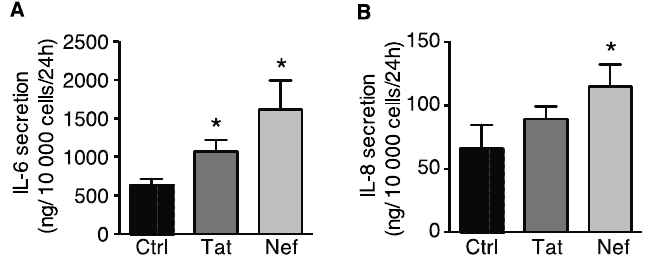
Figure 3. Elevated levels of interleukin (IL)-6 and IL-8 secreted into the culture medium of Tat- or Nef-treated ASCs. After 15 days of treatment with Tat or Nef, the levels of ( A ) IL-6 and ( B ) IL-8 in the culture medium from the last 24 h were determined with ELISAs ( n = 3, in duplicate). The results are expressed as the mean ± SEM. Experiments were performed in duplicate on ASCs isolated from di ff erent abdominal SCAT donors. * P < 0.05 vs. control different abdominal SCAT donors. * P < 0.05 vs. control cells.